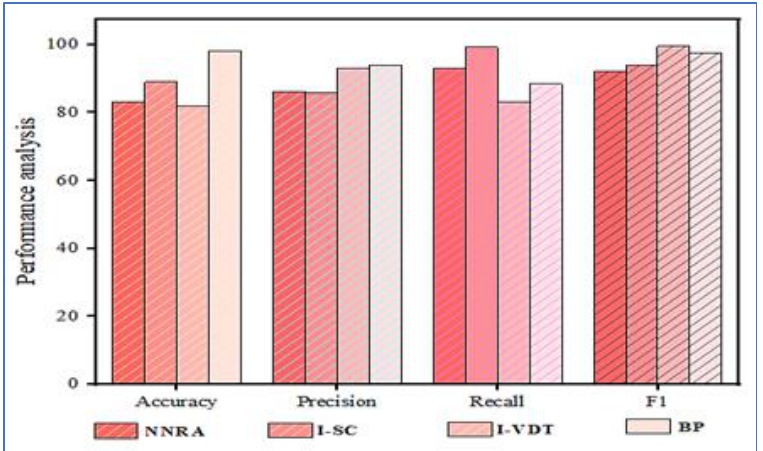
Figure 3. Classification performance on the data tracking the higher education neural network da- taset.